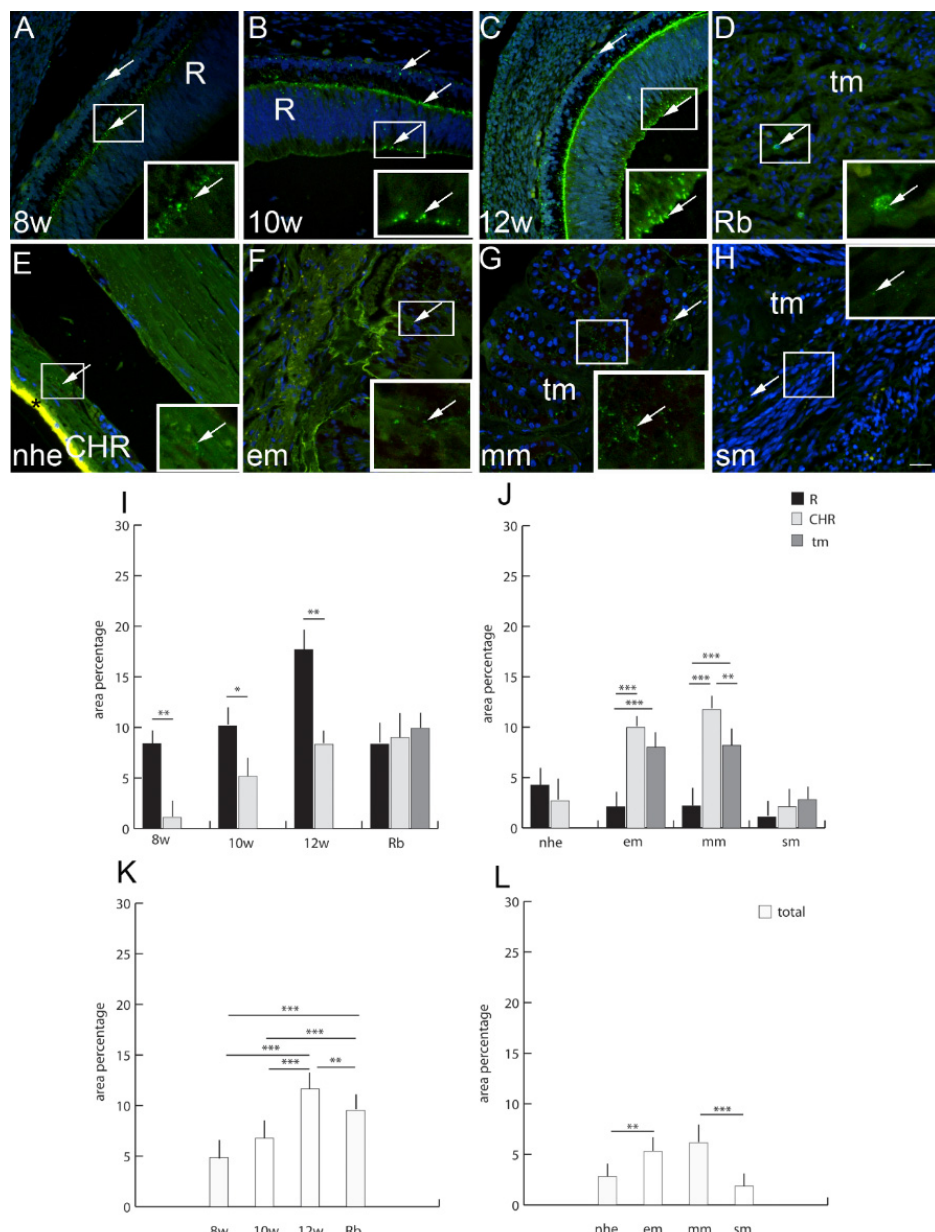
Figure 4. Connexin 43 (Cx43)-positive cells (arrows) can be seen in the eye section of an 8th-week (8 w) ( A ), 10th-week (10 w) ( B ) and 12th week (12 w) ( C ) human embryo, retinoblastoma (Rb) ( D ), normal human eye (nhe) ( E ), epitheloid melanoma (em) ( F ), mixoid melanoma (mm) ( G ) and spindle melanoma (sm) ( H ); R—retina, CHR—choroidea, tm—tumor tissue, *—autofluorescence. Immunofluorescence staining to Cx43 (green) merged to DAPI (blue nuclei), scale bar 25 μ m. The panel with graphs represents the area percentages of Cx43 in the retina (R), choroid (CHR) and tumor (tm) in the 8th-week (8 w), 10th-week (10 w) and 12th-week (12 w) human embryo, retinoblastoma (Rb), normal human eye (nhe), epitheloid melanoma (em), mixoid melanoma (mm) and spindle melanoma (sm) ( I , J ), and total area percentage of Cx43 ( K , L ). Data are shown as mean ± SD. Significant differences are indicated by * p < 0.05, ** p < 0.01, and *** p < 0.001. One-way ANOVA followed by Tukey’s multiple-comparisons test (comparison between Rb and uveal melanoma types), t-test (comparison between retina and choroid of developmental stages and normal human eye).